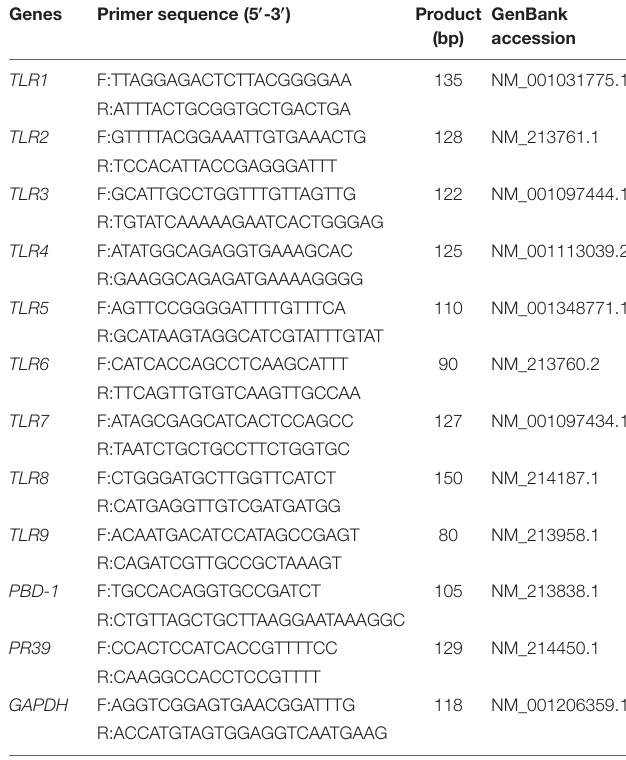
TABLE 2 | Primers sequences for